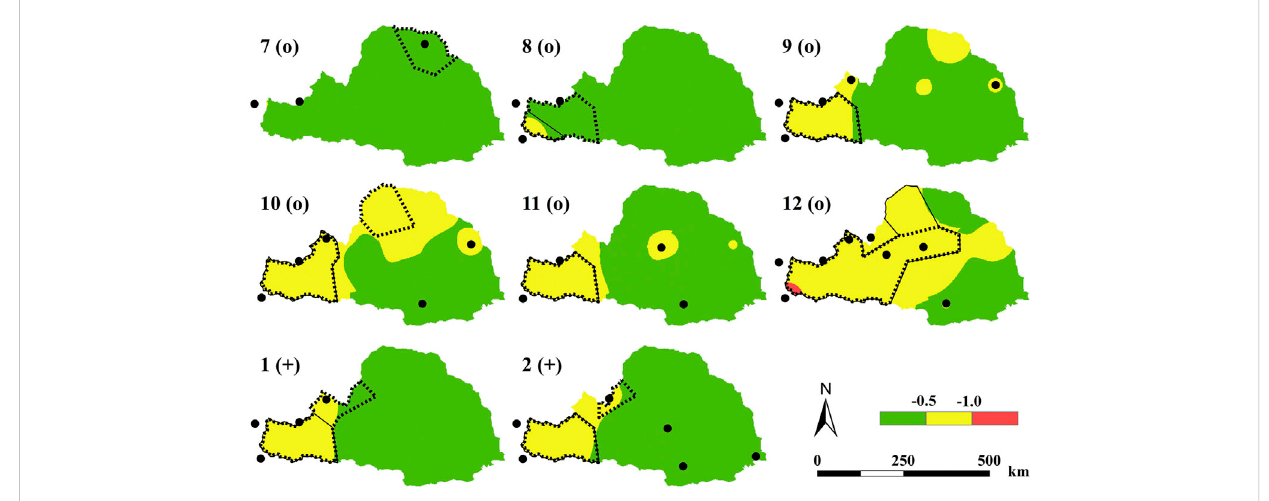
FIGURE 12 Spatial distribution of SPI6 averages from July of El Niño years (open circles) to March of the following year (pluses). Area within the black solid line, signi fi cant difference between the El Niño years and the remaining years, showing signi fi cant drought; area within the black dashed line, signi fi cant difference between El Niño and normal years, showing signi fi cant drought; solid circles, observatories with consistent anomalies among El Niño